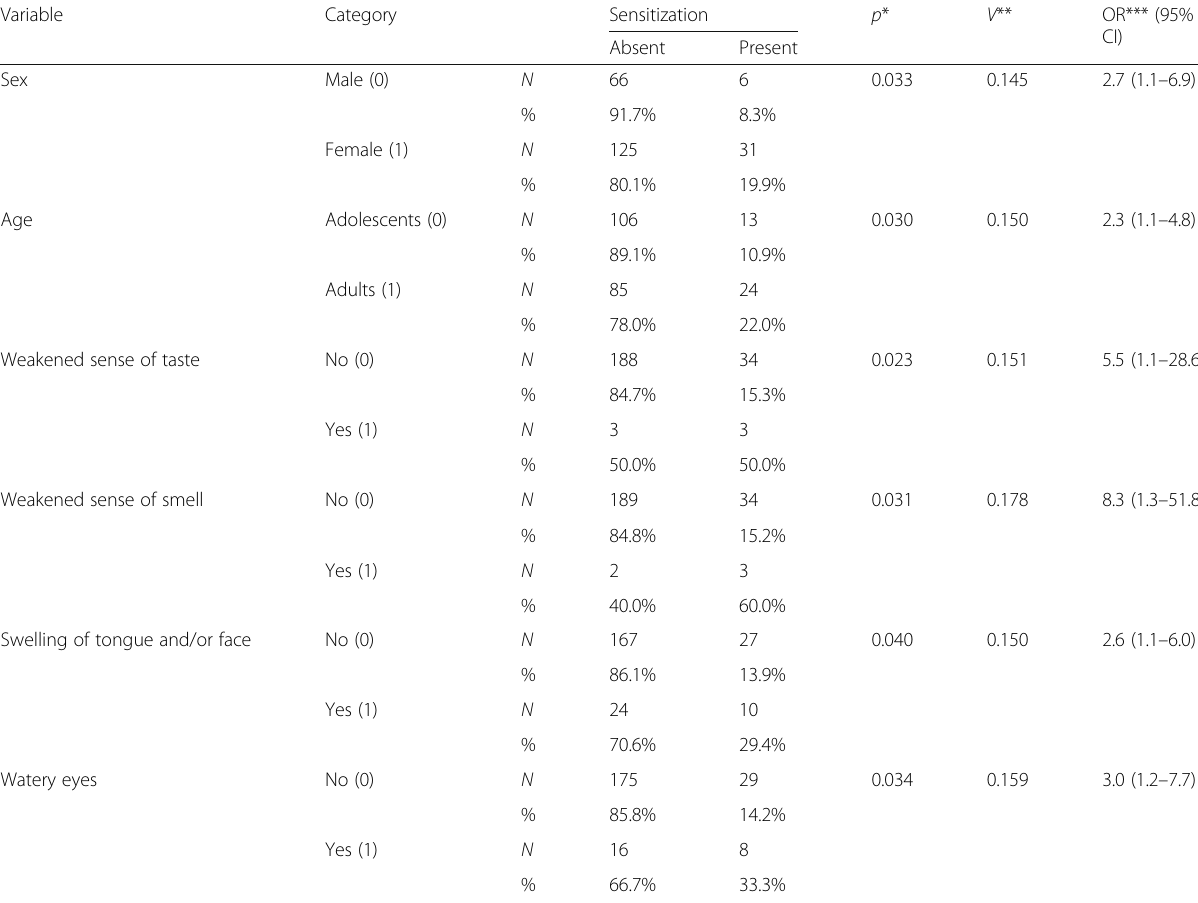
Table 1 Univariate predictors of nickel and/or titanium sensitization